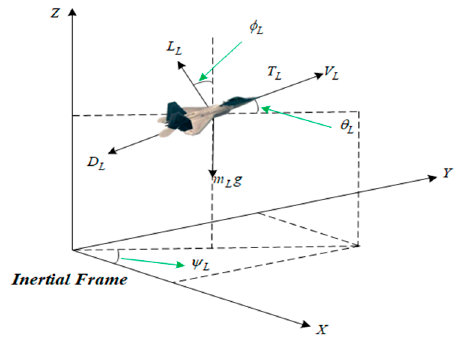
Figure 1. MAV model.